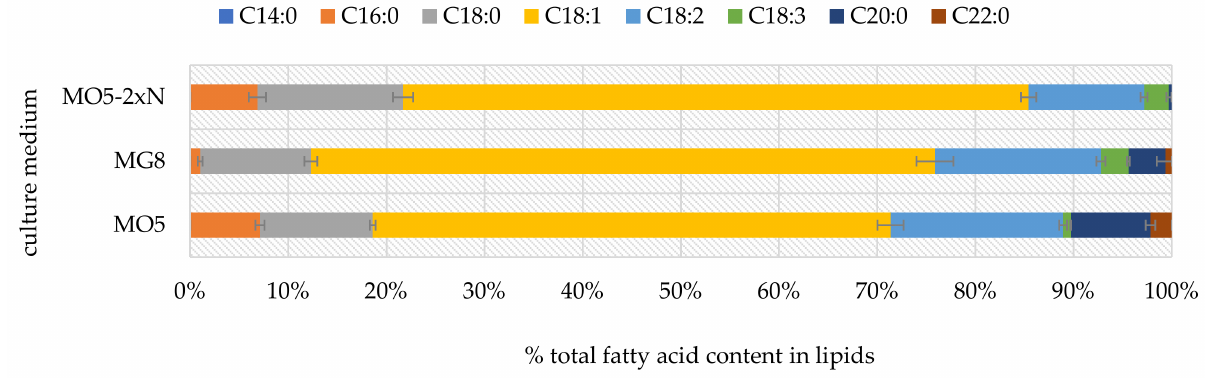
Figure 5. Fatty acid content in cellular lipids synthesized in MG8, MO5 and MO5-2xN media at 84th h of Y. lipolytica yeast culture in stationary growth phase. The error bars indicate standard